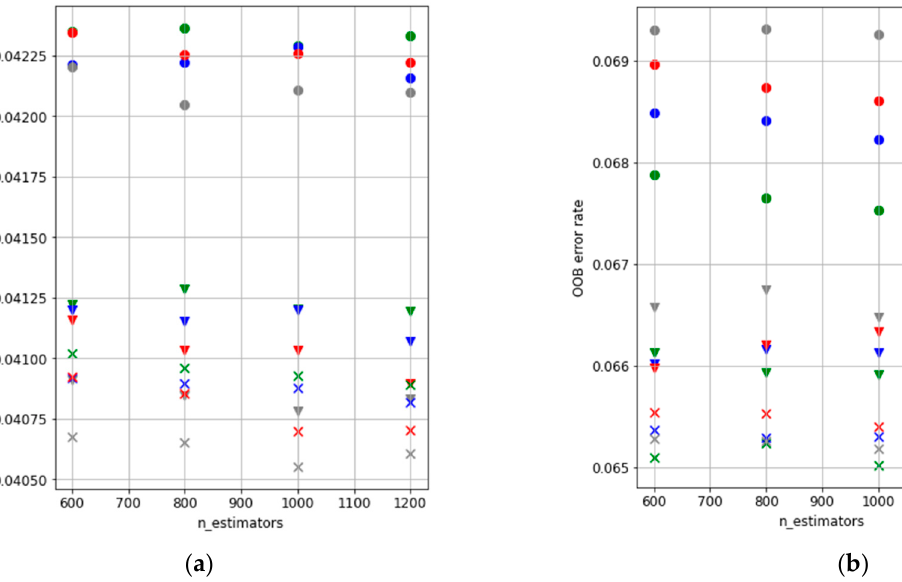
ple_split and max_features : ( a ) RF-OS; ( b ) RF-US.